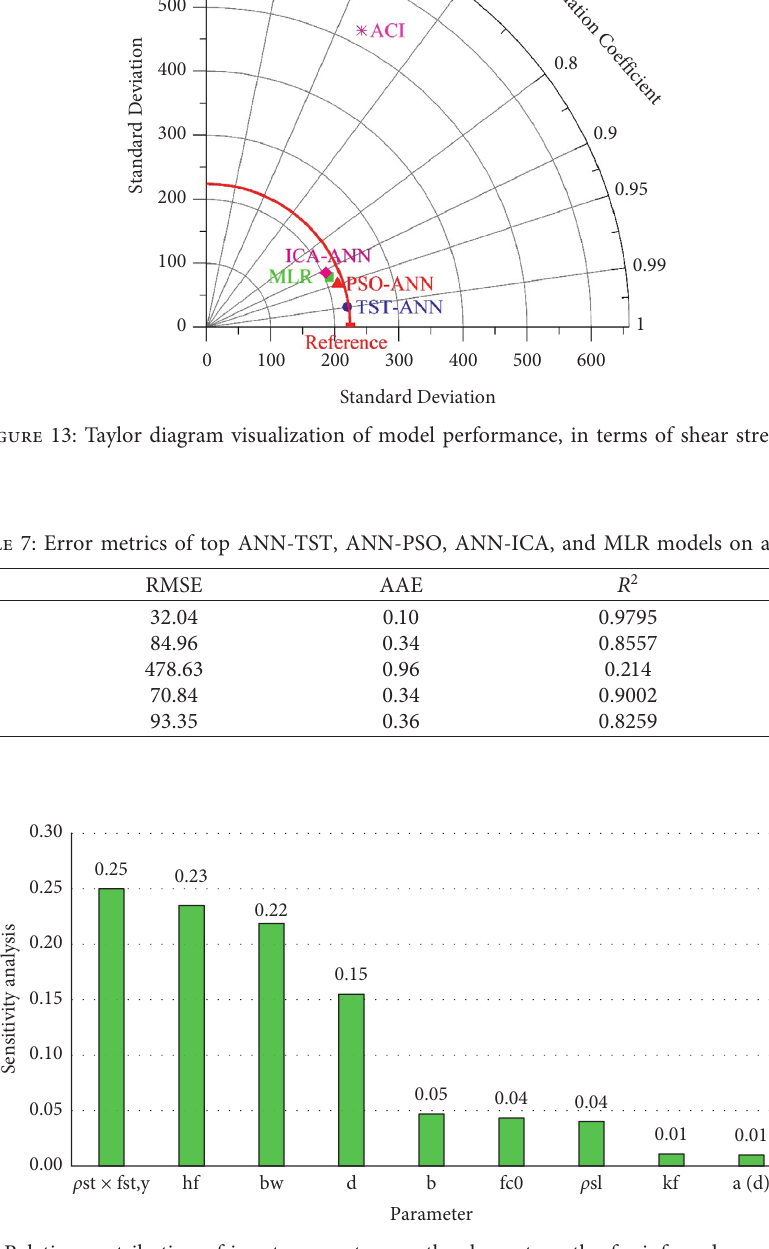
Figure 14: Relative contribution of input parameters on the shear strength of reinforced concrete